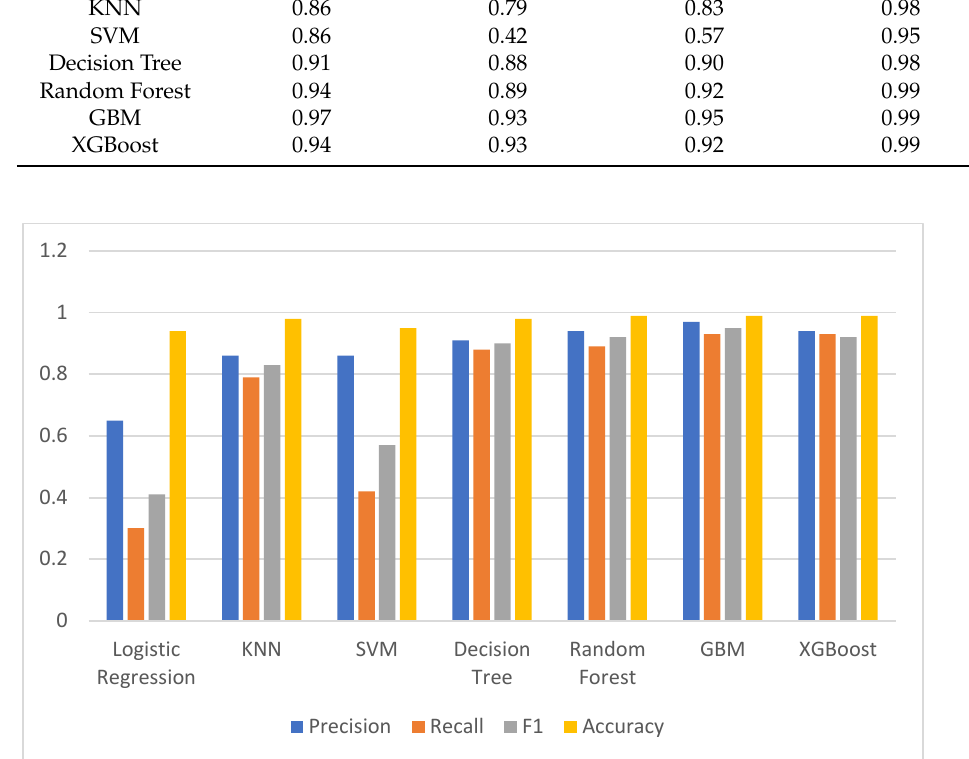
Figure 9. Decision tree example for the parameters of welding process